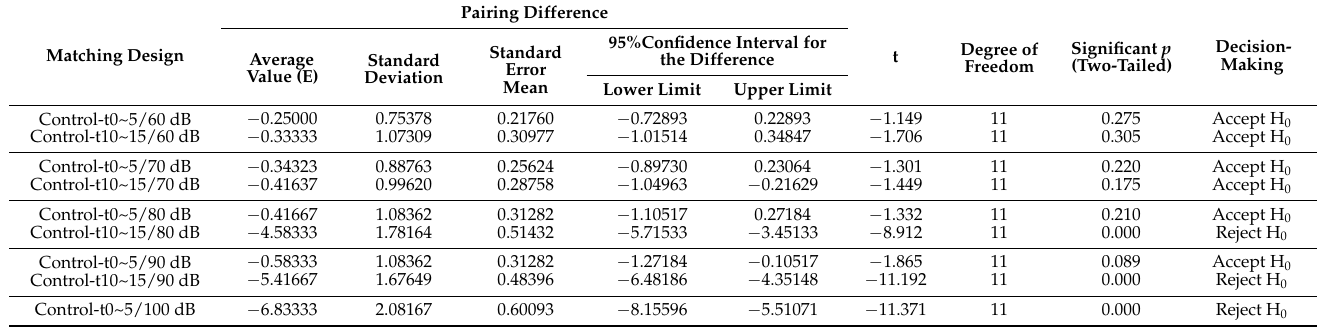
Table 6. Paired sample t -test analysis results of heart